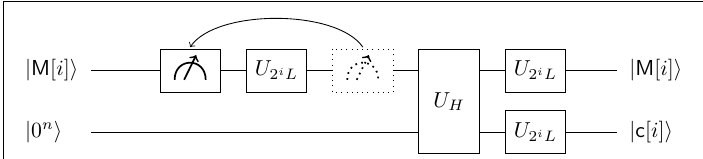
Figure 4: The quantum sub-circuit implementing Line 4 in the OCB 2 . Enc ( · ) oracle in hybrid G , namely “ c [ i ] ← 2 i L ⊕ H (2 i L ⊕ M [ i ])” (see Fig. 3 for reference). Here, the (2 ,i, 1) unitary gate U H models (internal) access to the random function H : { 0 , 1 } n → { 0 , 1 } n as U H | X i | Y i = | X i | Y ⊕ H ( X ) i , for arbitrary n -bit strings X , Y . Similarly, the unitary